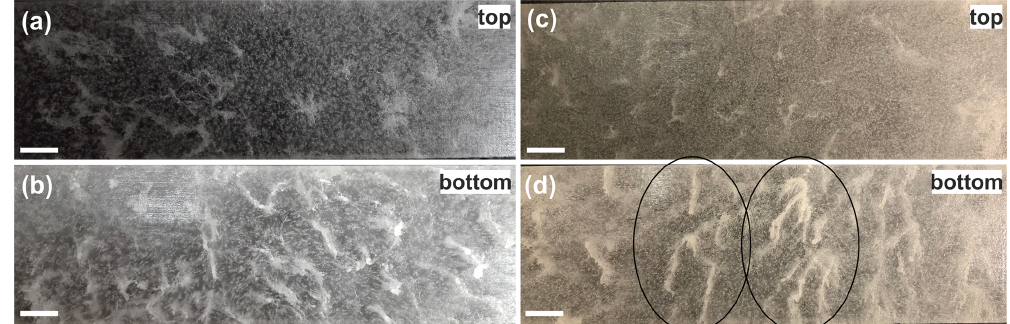
Figure 3. Photographs of saline ice samples of lower salinity (3.0 ± 0.9ppt) from the top (a) and bottom (b) of an ice block and saline ice samples of higher salinity (5.9 ± 0.6ppt) from the top (c) and bottom (d) of an ice block. The concentration of whitish features along the width of a sample in (d) is shown inside circles, which is a predominant place for a crack to initiate. The columnar grains run in and out of the images. Scale bars: